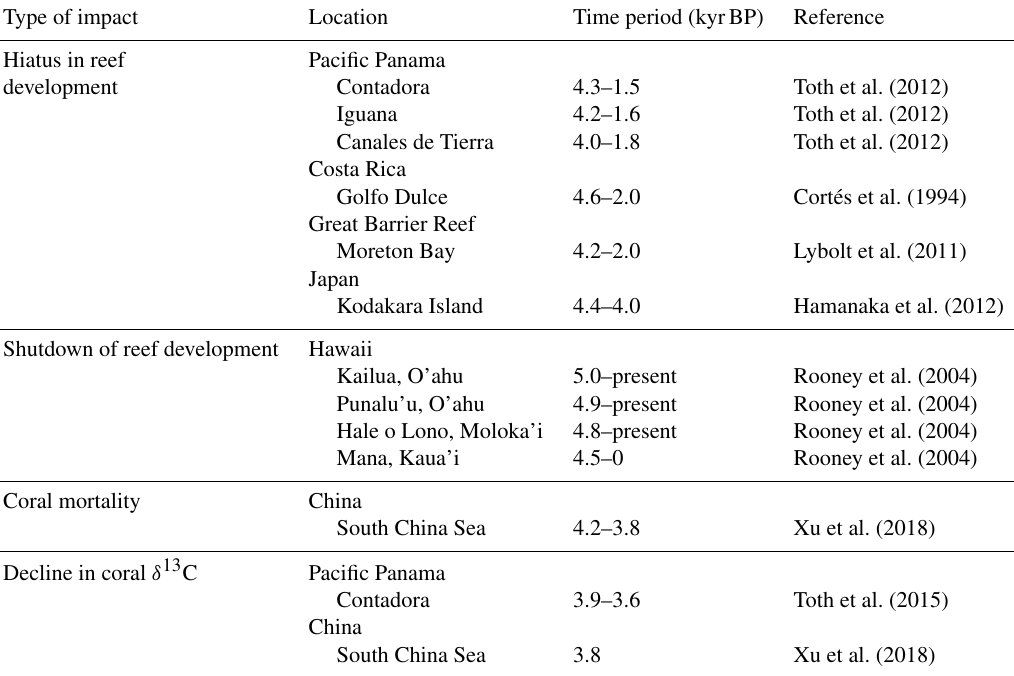
Table 1. Summary of records of perturbations to coral reef ecosystems around the time of the 4.2ka event. Reported radiocarbon ages were calibrated with the marine radiocarbon curve and regional marine reservoir age corrections, using CALIB software (v.7.0.2; Stuiver et al.,